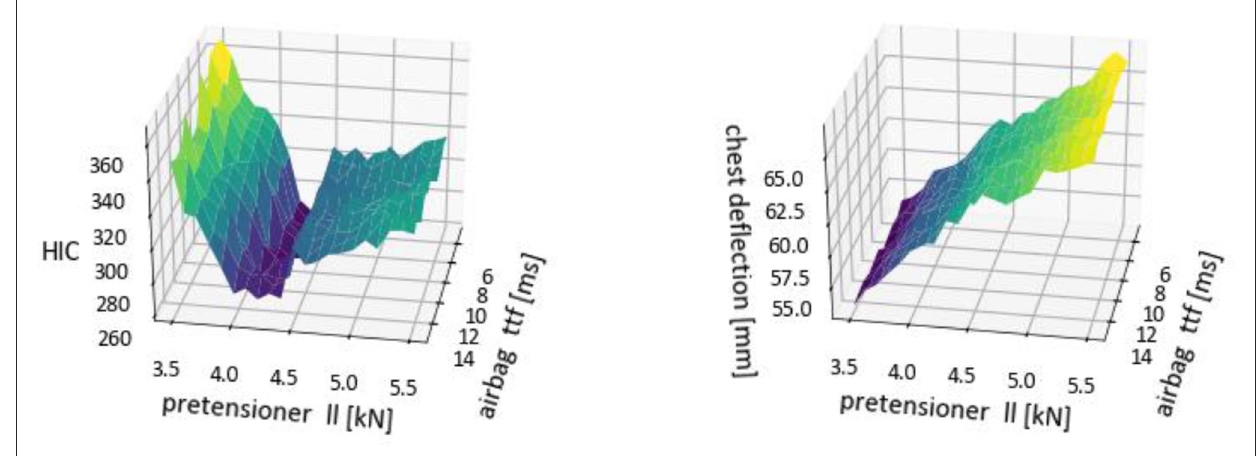
FIGURE8 Exemplary response surface of HIC 36 and chest deflection in two dimensions for the retractor pretensioner load limiter and the airbag time to fire.